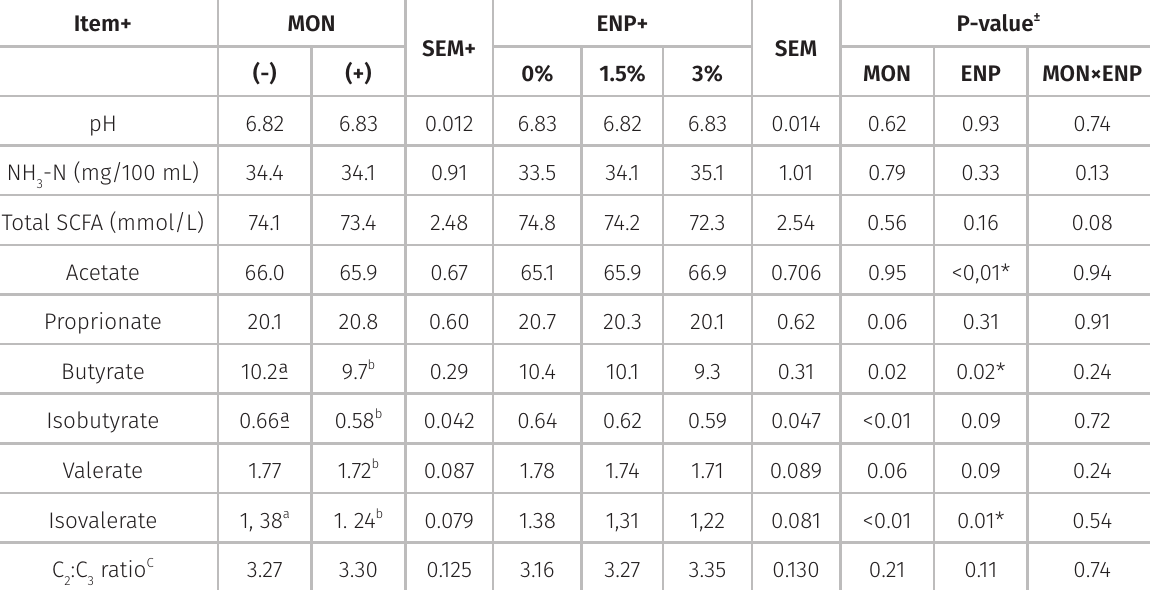
Table IV. Effect of inclusion encapsulated nitrate product (ENP) in diets without (-) or with (+) monensin (MON) on fermentation